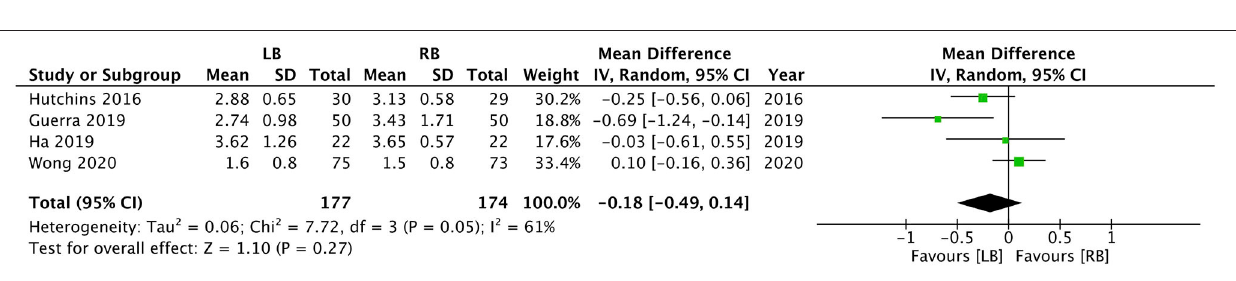
FIGURE 3 | Forest plot of length of hospital stay in days for LB vs. RB for TAP block.